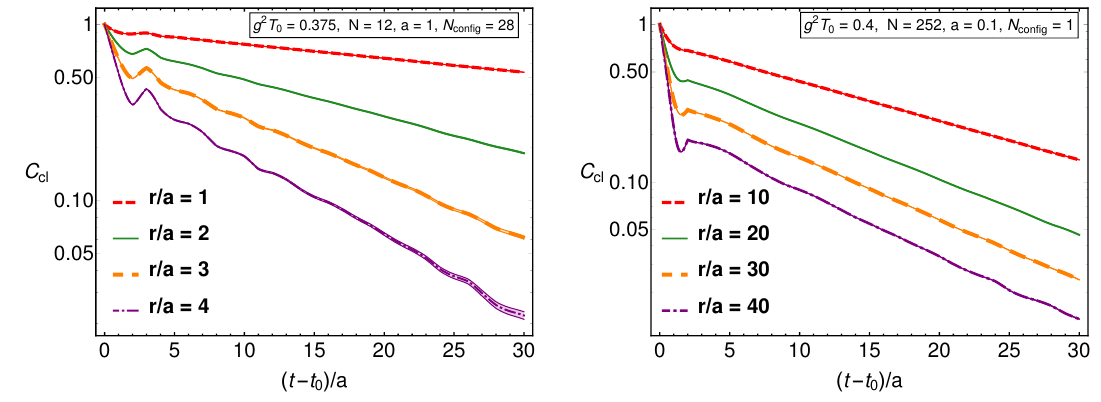
Figure 5 . Examples of the classical Wilson loop as a function of time for lattice spacing a = 1 and spatial separation values r/a = { 1 , 2 , 3 , 4 } (left), and for lattice spacing a = 0 . 1 and spatial separation values r/a = { 10 , 20 , 30 , 40 }